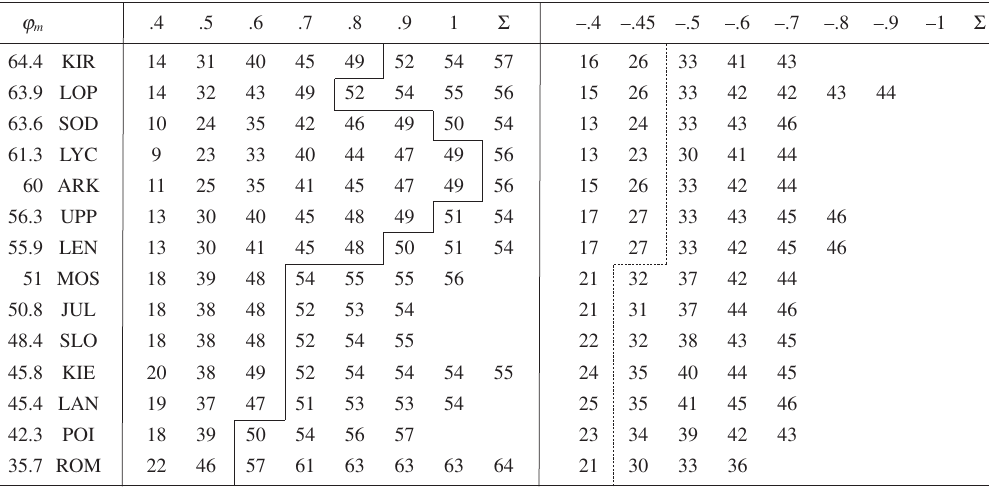
Table II. Percentage of positive ( left ) and negative ( right ) disturbances which does not exceed the respective variability level – ‘depth’ ( x -axis). Greek ‘ Σ ’ denotes total percentage of positive/negative storms. Top to bot- tom: European, Asian, Australian and North American